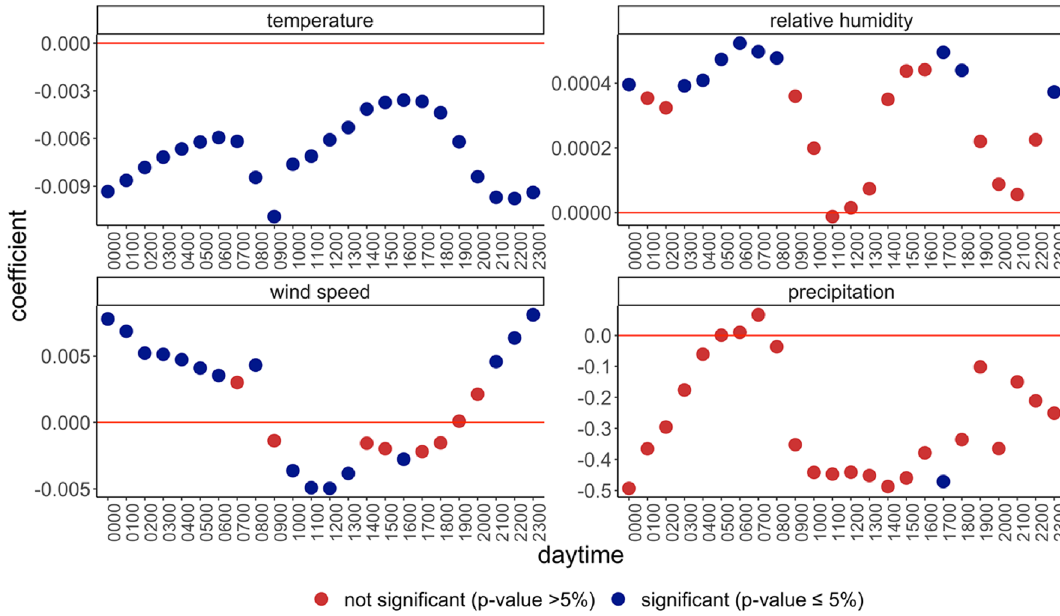
Figure 2. The effect of different weather indicators varies with daytime. The effect of different weather indicators at t-7 (at 12:00 local time) on new cases throughout the day. The outcome variable is (log) new cases. The x-axis shows the daytime between 00:00 and 23:00 (local time). Standard deviations of the OLS estimations are based on robust standard errors clustered at the county level. Country and state-date fixed effects applied. N = 1,207,317.